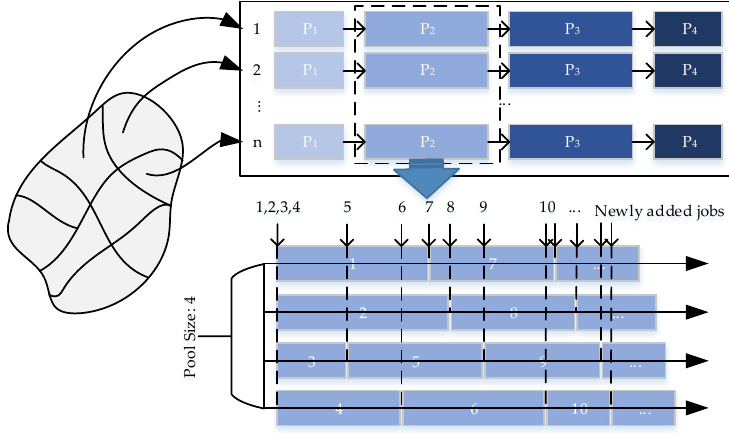
Figure 5. Stream scheduling of asynchronous compute units (P 1 , P 2 , P 3 and P 4 are four different procedures; P 1 is data moving, P 2 is data clipping, P 3 is overlay operation, and P 4 is area calculation).